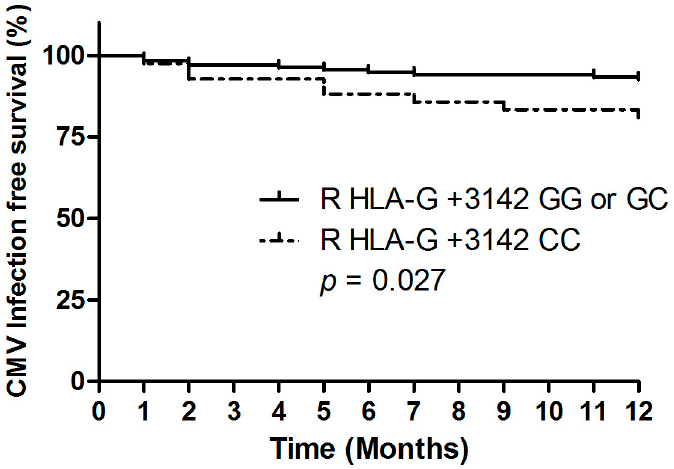
Figure 1. Association between the transplant recipient HLA-G +3142 C>G polymorphism and CMV infection during first year of living-donor kidney transplantation. Recipients with a HLA-G +3142 CC genotype had a significantly increased likelihood of CMV infection.